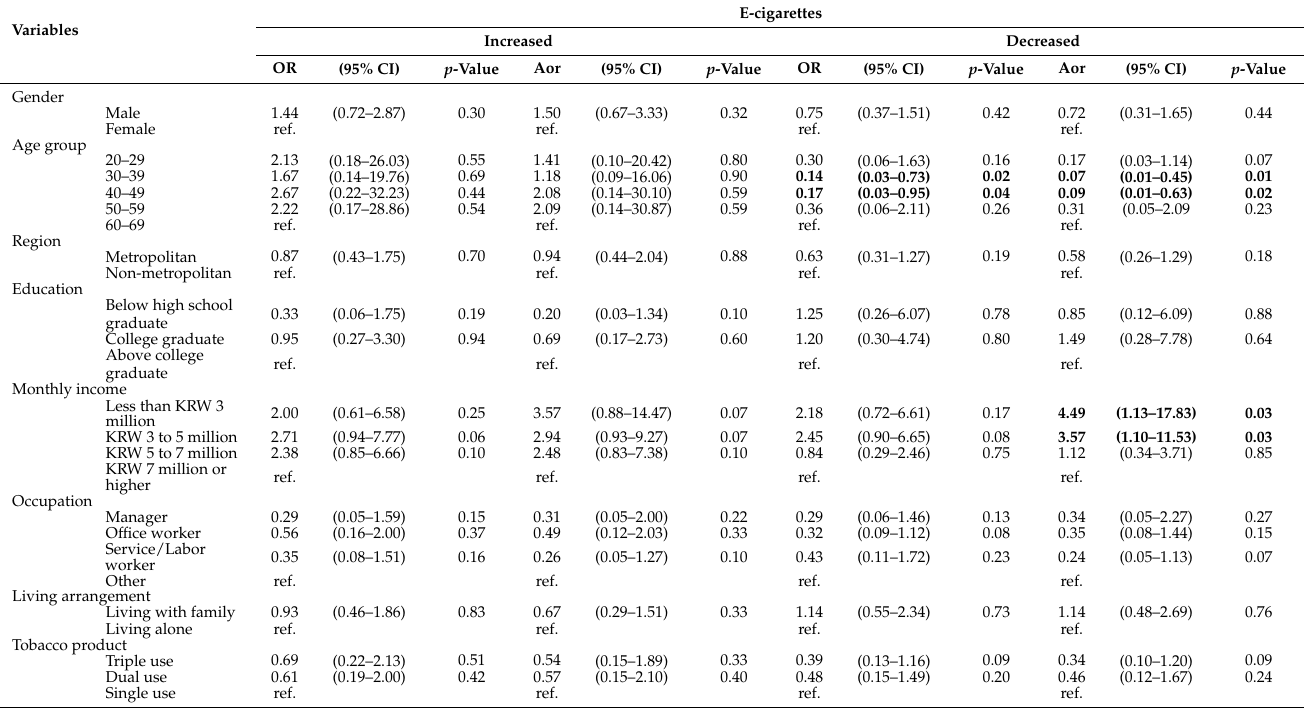
Table 5. Factors associated with the change in usage of